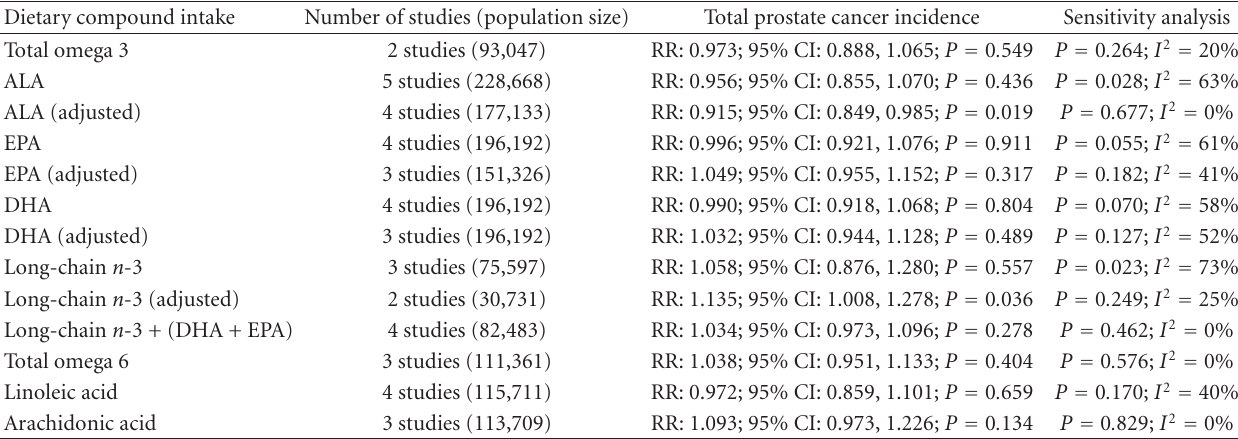
Table 2: Meta-analysis statistical summary on relationship of dietary omega 3 and omega 6 compound with prostate cancer risk. Dietary compound